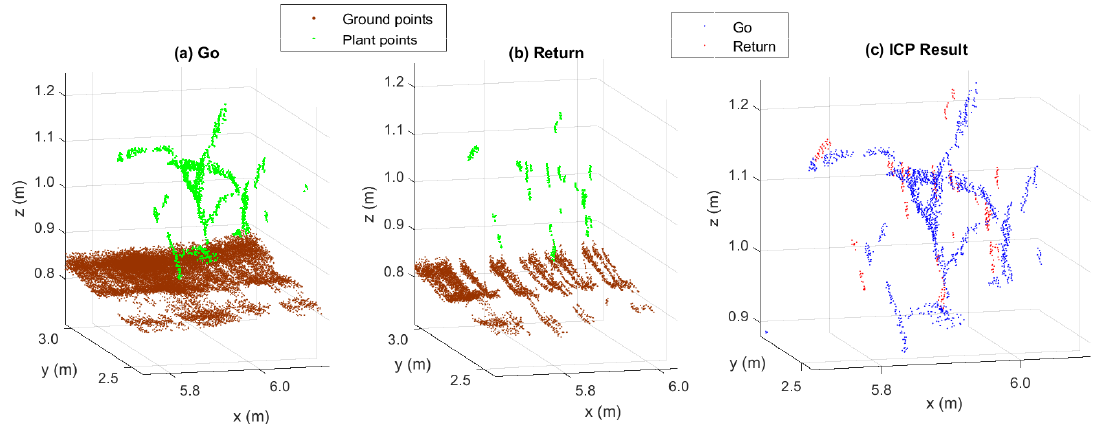
Figure 10. ( a ) RANSAC go results; ( b ) RANSAC return results; and ( c ) ICP result of the aerial point clouds for the vertical LiDAR’s orientation when going and returning at path 1 and row 2 for a specific row interval.